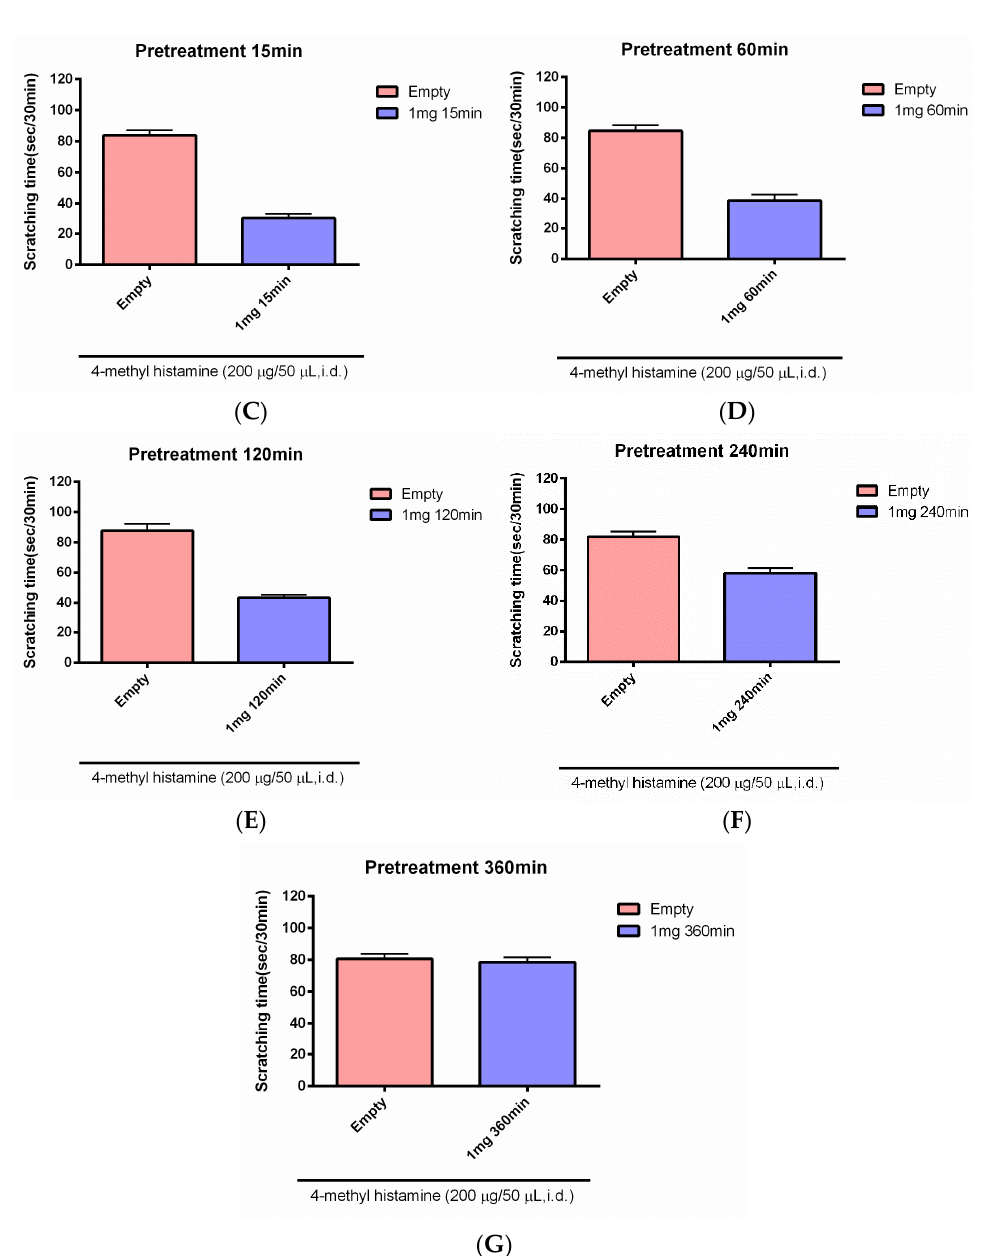
Figure 5. Dose–response ( A , B ) and time course ( C – G ) of the efficacy of NanoBEO on 4-methyl histamine-induced scratching behavior. The effectiveness of NanoBEO increases with the dose, reaching statistical significance at 0.5 and 1 mg. The effect is not statistically significant when pre-treatment is performed at the following time points: 15 min, 60 min, 120 min, 240 min, and 360 min. Each value represents the mean ± S.E.M. of n = 6 mice. The value of p < 0.05 is considered statistically significant. ** p < 0.01.